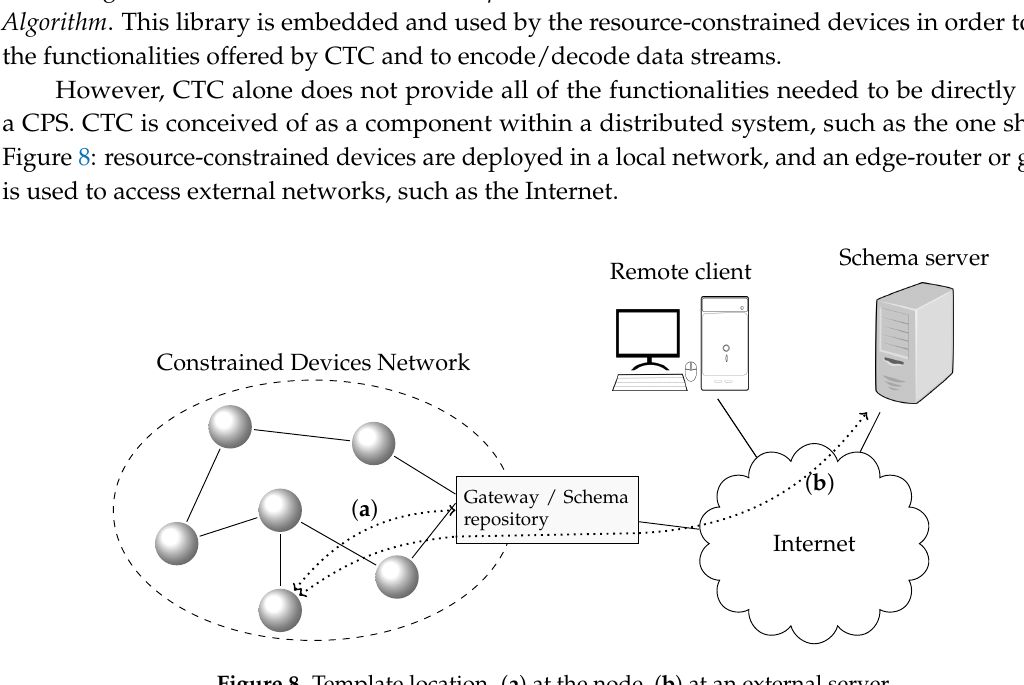
Figure 8. Template location. ( a ) at the node, ( b ) at an external